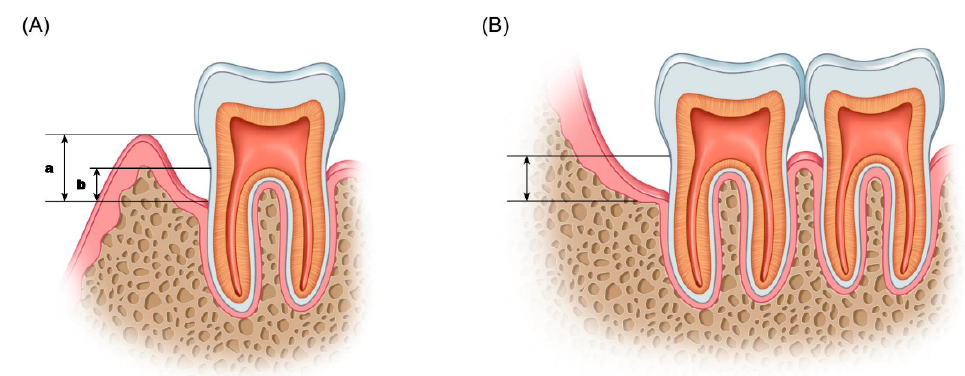
Figure 1. Schematic illustration for measurements. ( A ) Pocket depth is defined as the distance between the free gingival margin and the bottom of the periodontal pocket (indicated as (a)). Clinical attachment level is defined as the distance between the cementoenamel junction and the bottom of the periodontal pocket (indicated as (b)). ( B ) The amount of bony defect was defined by the distance between the cementoenamel junction of the second molar and the bottom of the bony defect in the distal surface of the second molar.